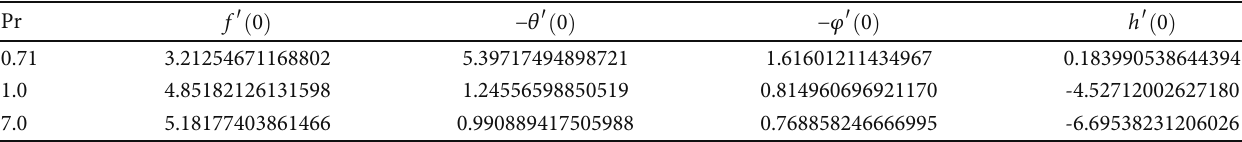
Table 1: Values of skin friction coe ffi cient, heat transfer and mass transfer for Prandtl number variation with γ = 45 ° , M = 2, c = 0 : 5, R = 0 :